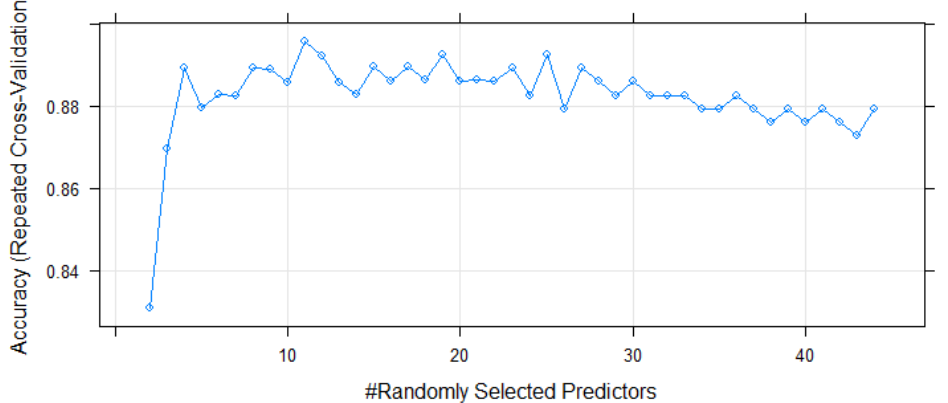
Figure 7. Cross-validation results to obtain the best mtry of the RF model.